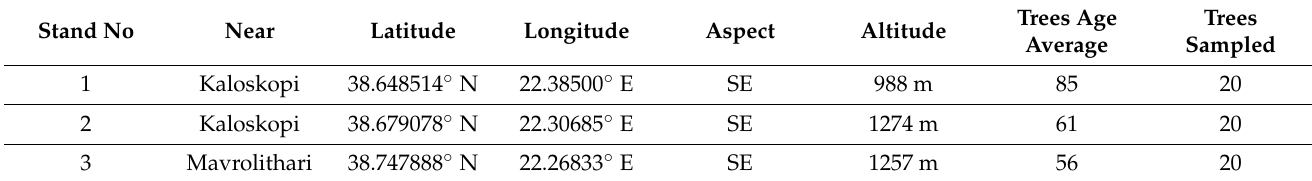
Table 1. Coordinates and case studies characteristics .